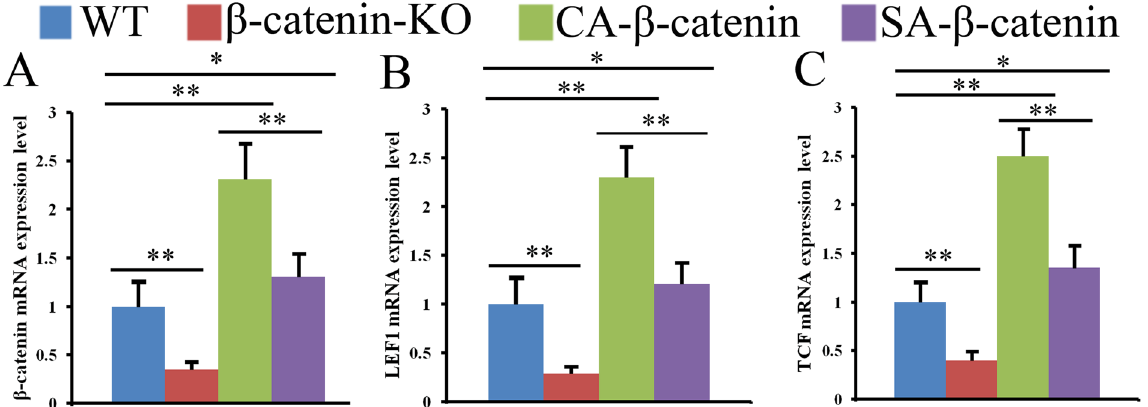
Figure 1. Wnt/ β -catenin signaling pathway was deleted or activated in different levels at fracture sites in WT, β -catenin-KO, CA- β -catenin and SA- β -catenin mice. The mRNA expression level of β -catenin, TCF and LEF1 were examined by RT-PCR ( A – C ). The values are expressed as the means ± SDs. (n = 6/group, * p < 0.05, ** p <